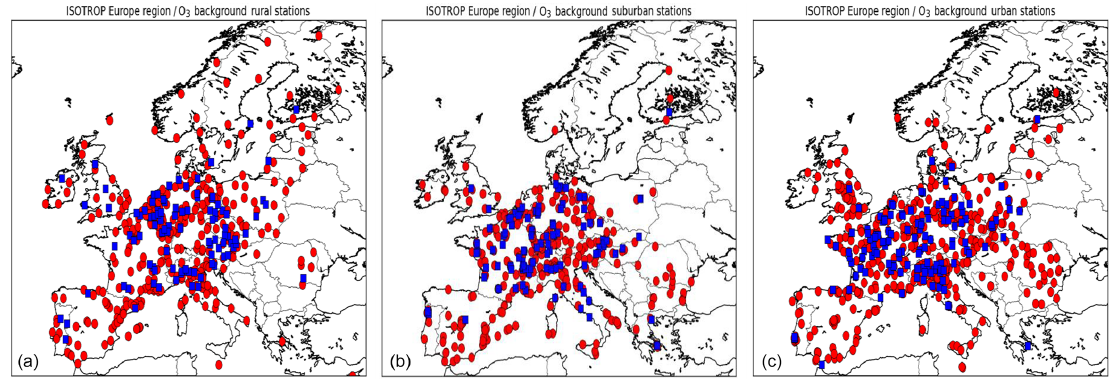
Figure 5. Map of the sampling location for the ozone stations for the European region: (red circles denote assimilation stations and blue squares denote validation stations) (a) rural background stations, (b) suburban background stations and (c) urban background